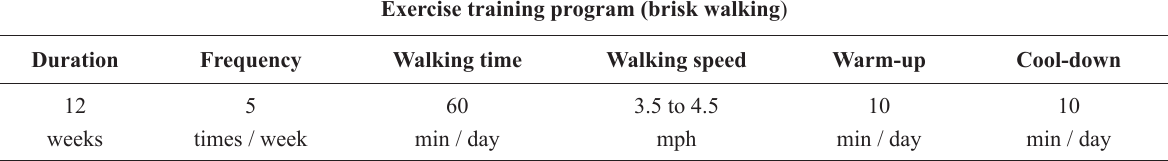
Exercise training